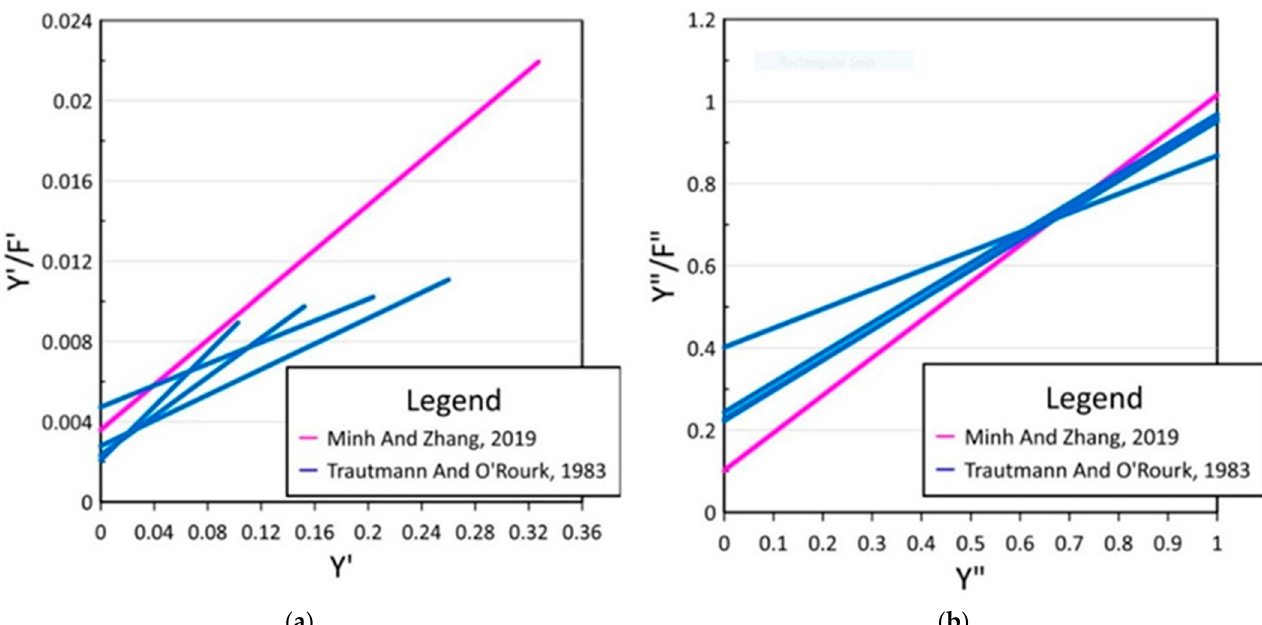
Figure 9. Diagram of ( a ) Single- and ( b ) Double-normalization for very dense sand. Experiments performed by [7,18]. Table 6. Maximum and minimum values of very dense sand.